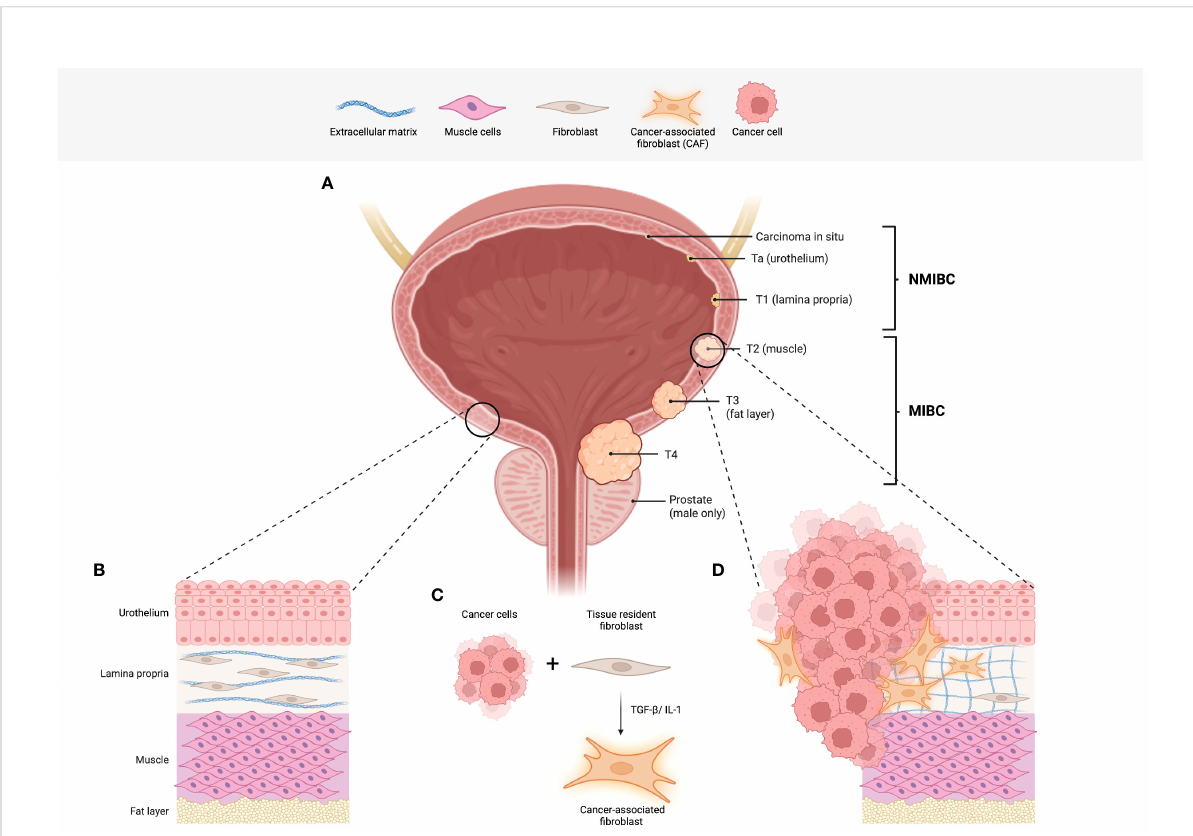
FIGURE 1 Bladder cancer staging and the role of fi broblasts. (A) An illustration of the human bladder, including the tumour (T stages) of bladder cancer. Commencing in the urothelium, NMIBCs describe carcinoma in situ (in the inner most layer of the urothelium) Ta (urothelium only) and T1 tumours. T1 tumours have in fi ltrated the fi rst sub-urothelial layer known as the lamina propria. To progress to stages T2-4, invasion into the muscle layer is required and is the determining factor in the diagnosis of MIBC. (B) A representation of the physiological histology observed in the human bladder. Of note, fi broblasts found in the lamina propria function to produce and maintain collagen and other fi bres that make up the loose connective tissue. (C) Interactions between tumour cells and tissue resident fi broblasts are one of the likely origins of cancer- associated fi broblasts (CAFs). (D) The illustration depicts the histological changes observed in bladder cancer including the presence of CAFs. In addition, there is an increase in extracellular matrix deposition and remodelling. Abbreviations: non-muscle invasive bladder cancer (NMIBC), muscle invasive bladder cancer (MIBC), cancer-associated fi broblasts (CAFs). Figure created with